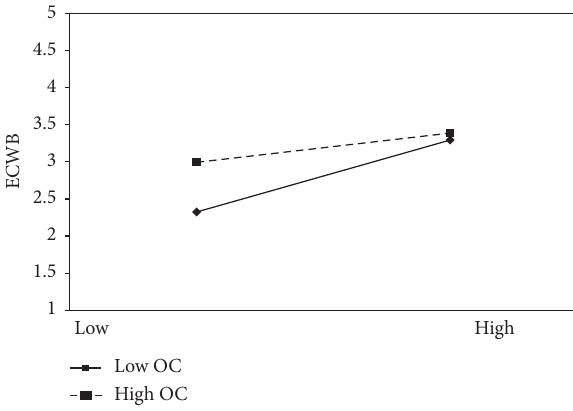
Figure 3: Moderating effect